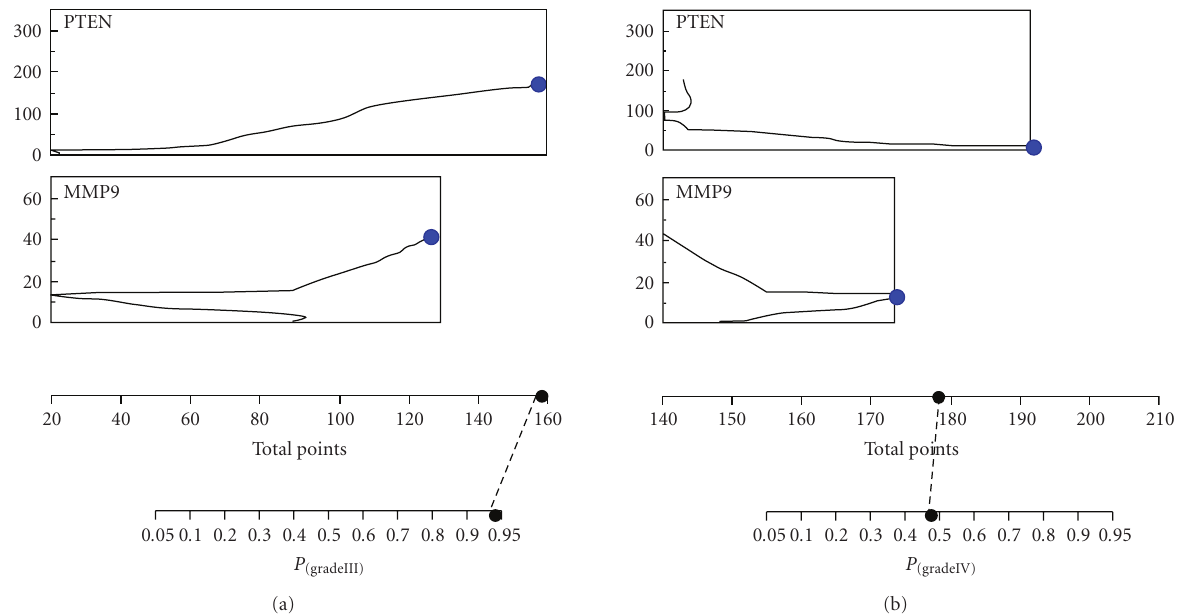
Figure 5: Nomogram analysis of PTEN and MMP9 expression within the di ff erent WHO grades of malignancy (III, IV) of the astrocytomas specimens. Points and total points axes indicate the points attributed to each variable value and the sum of the points for each variable, respectively. P axes indicate the predicted probability that relates PTEN or MMP9 quantitative expression to each WHO tumor malignancy grade.